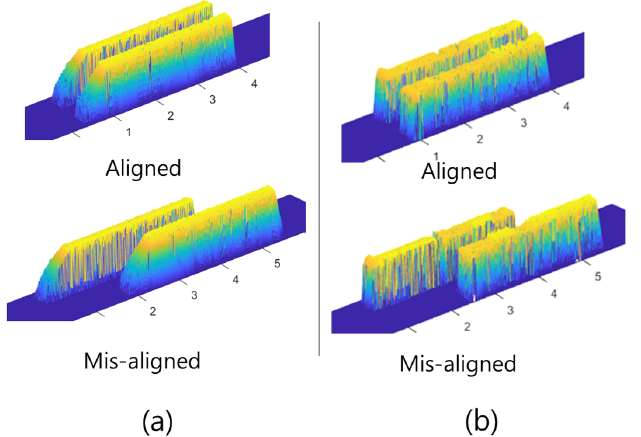
Figure 10. Comparison of 3D-reconstructed results for object 4: ( a ) before combination with only the FLS used and the ( b ) proposed